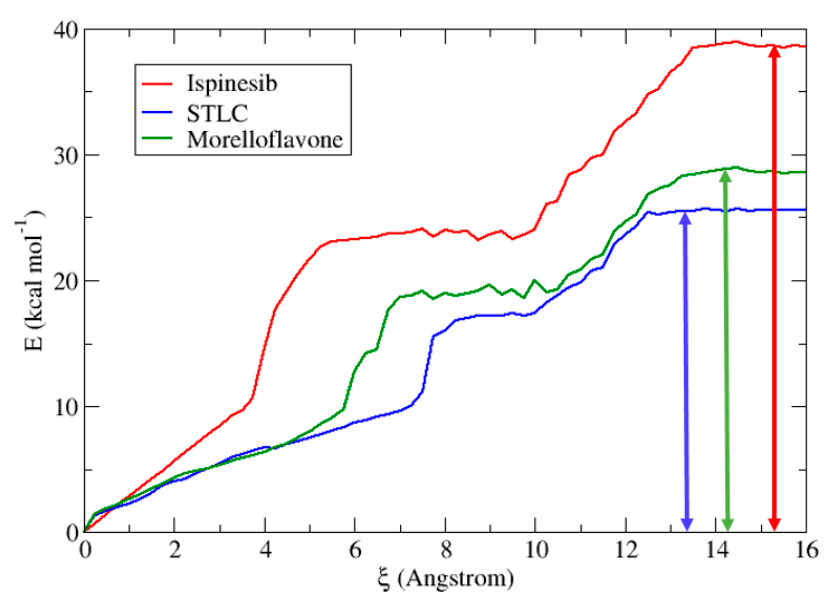
Figure 7. Potential of mean force along the reaction coordinate for the dissociation of inhibitors in Eg5 protein. We show the behavior of ispinesib (red), STLC (blue), and MF (green). The vertical solid double-headed arrows indicate the free energy barriers for the inhibitor dissociations.